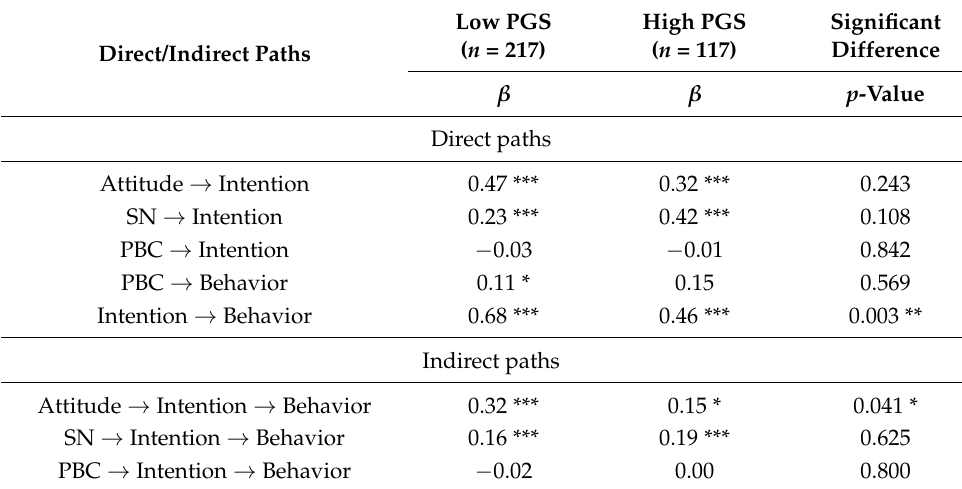
Table 3. Group differences: Direct and indirect